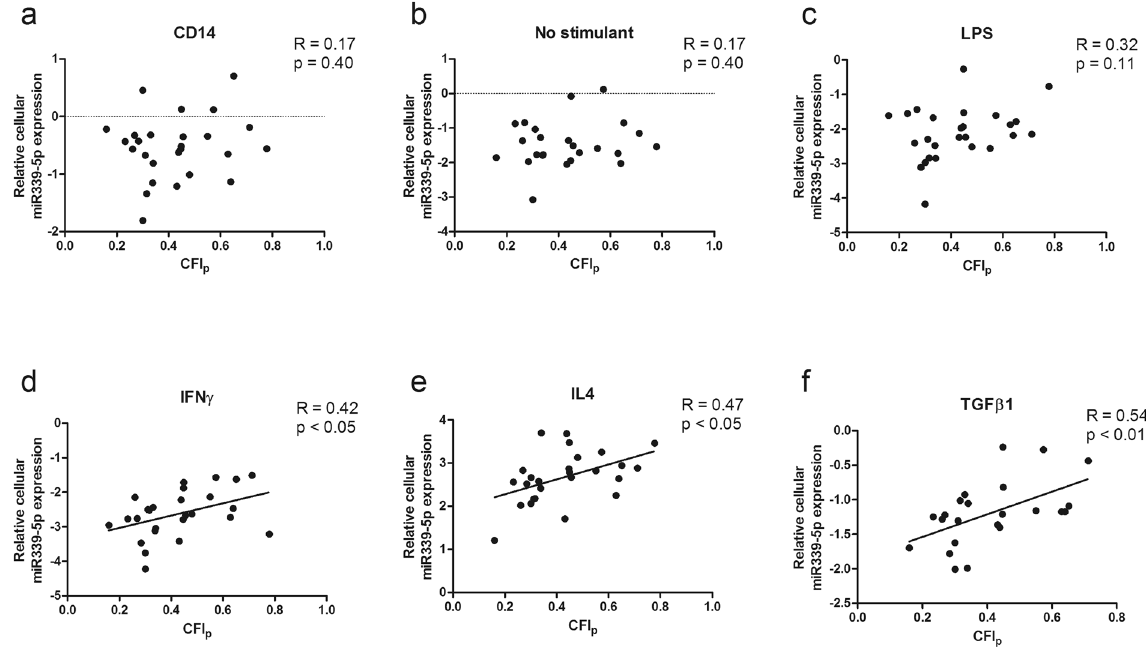
Figure 3. Correlation between CFI p and relative miR339-5p expression in each monocyte/macrophage group. Relative miR339-5p is significantly correlated with CFI p in certain monocyte/macrophage phenotypes (IFN ɣ , IL4, TGF β